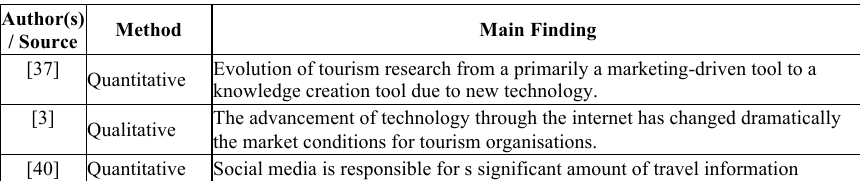
Table 1. Review and Analysis on Social Media and Tourism